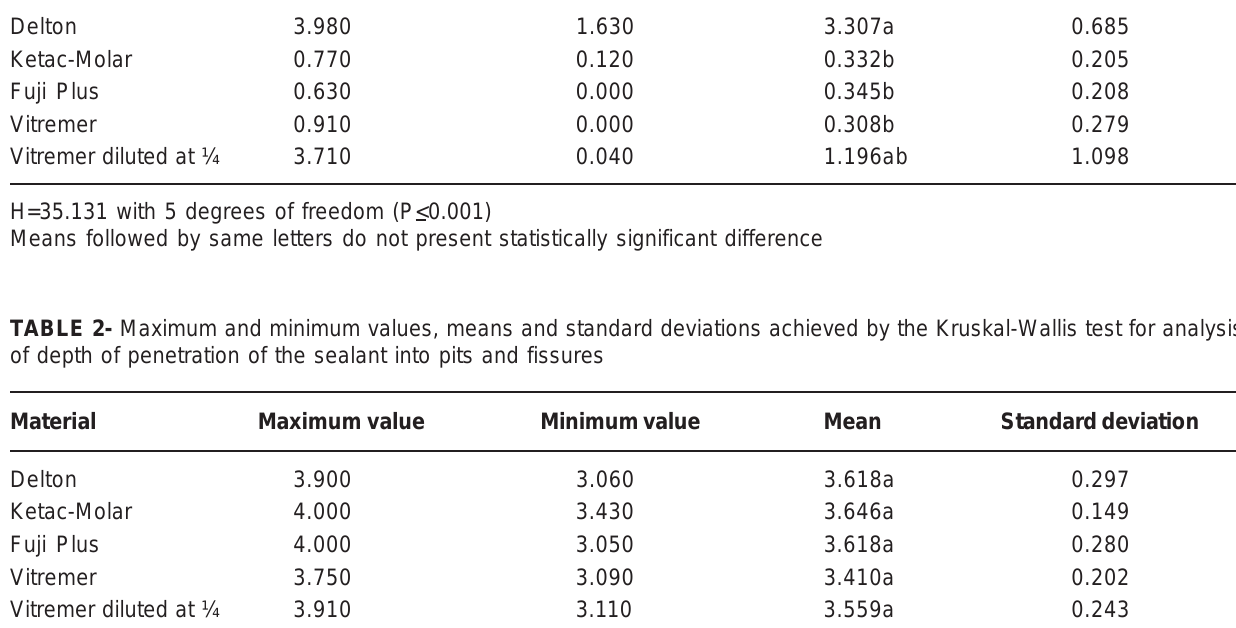
H= 10.589 with 5 degrees of freedom